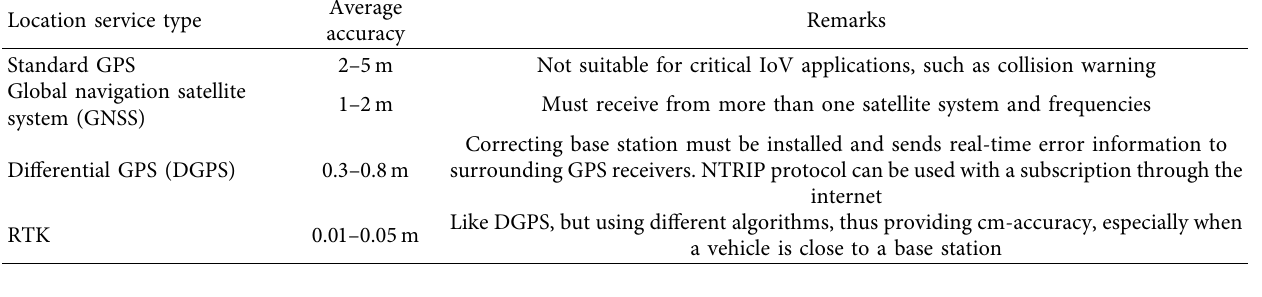
Table 1: Accuracy of the common location service types.